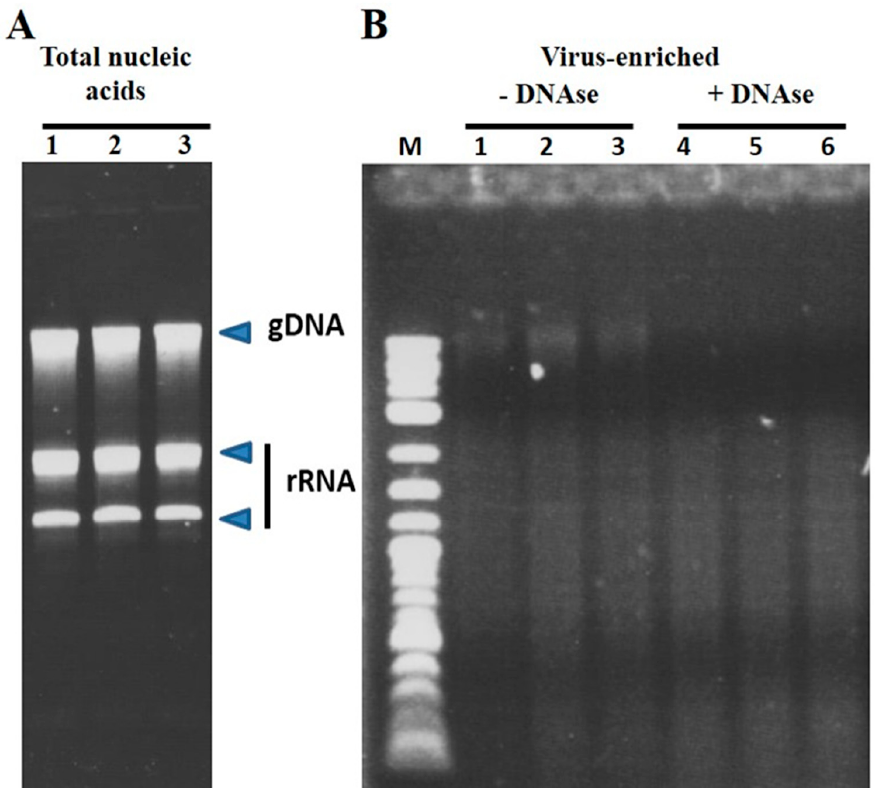
Figure 1. Agarose gel electrophoresis comparing total RNA prepared from sugar beet roots versus using virus-enriched RNA. ( A ) Typical preparation of total nucleic acids from roots of 6-week-old sugar beet plants is dominated by genomic DNA and ribosomal RNA. ( B ) Virus-enrichment removes the bulk of the cellular RNA, although additional DNase treatment (compare -DNase and +DNase lanes) is required to remove residual genomic DNA in preparing the sample for RNAseq. A DNA size standard (M) is included to monitor the approximate size of the RNA population.